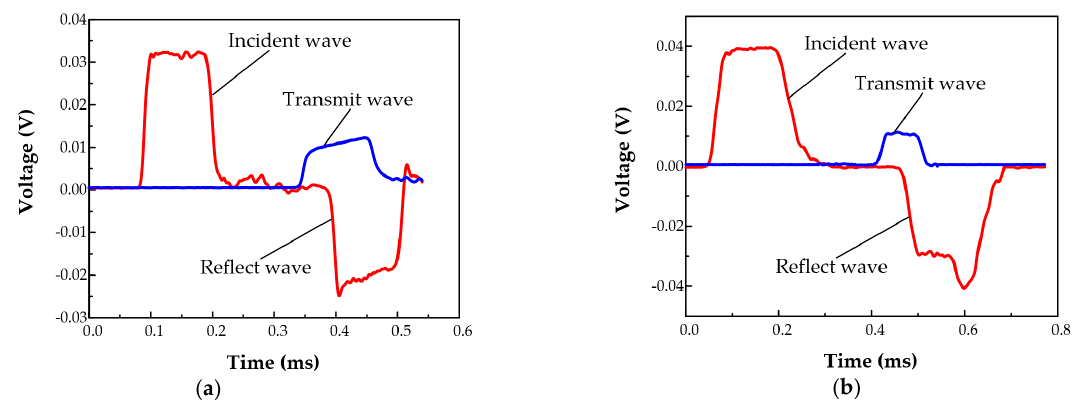
Figure 9. SHPB simulation model.